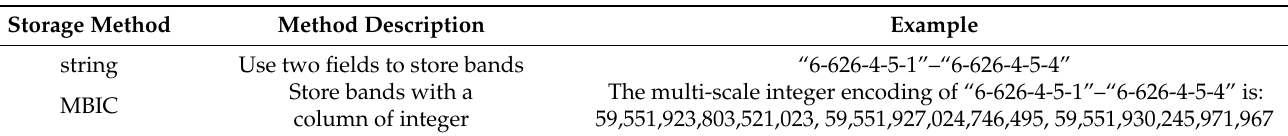
Table 4. Comparison of two coding